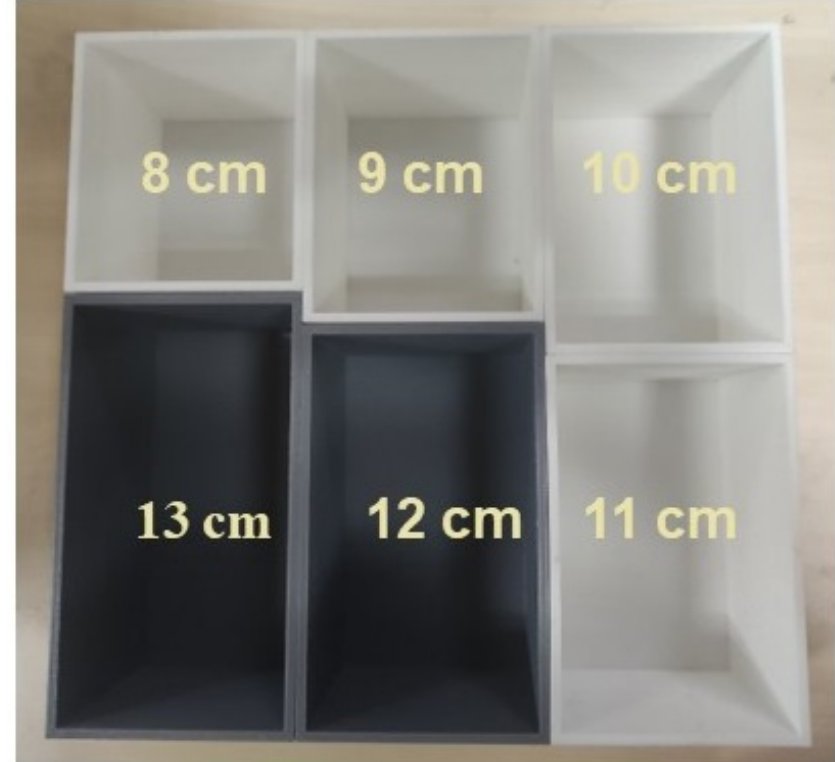
Figure 8. Sample containers with different thicknesses.